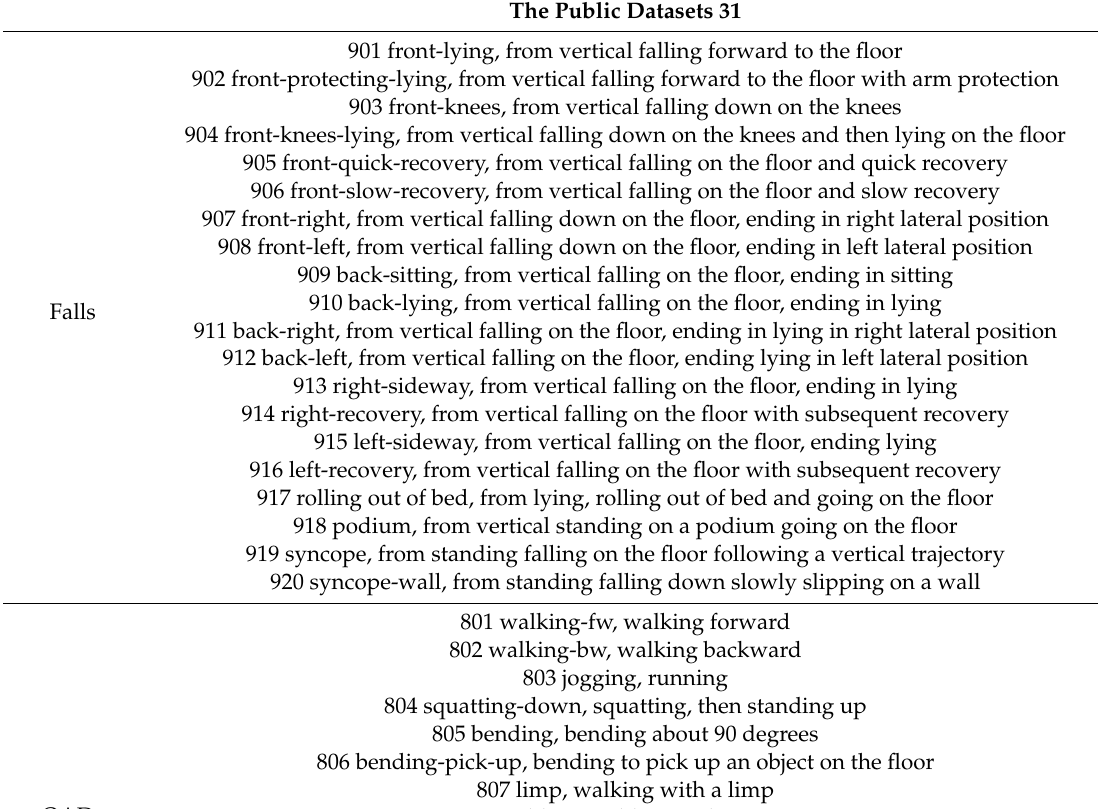
Table 8. The features of our the public datasets